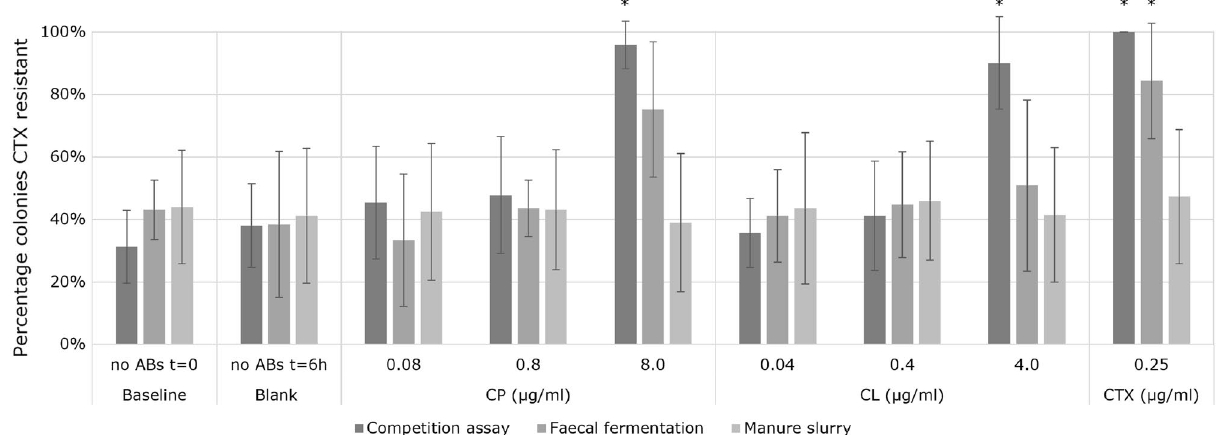
Figure 1. Average and standard deviation of the percentage of CTX resistance of E. coli in rich media, fecal fermentation and manure slurry experiments at different concentrations of CP, CL and CTX. * p value ≤